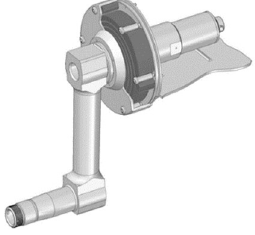
Figure 6. The package of logarithmic spiral springs.